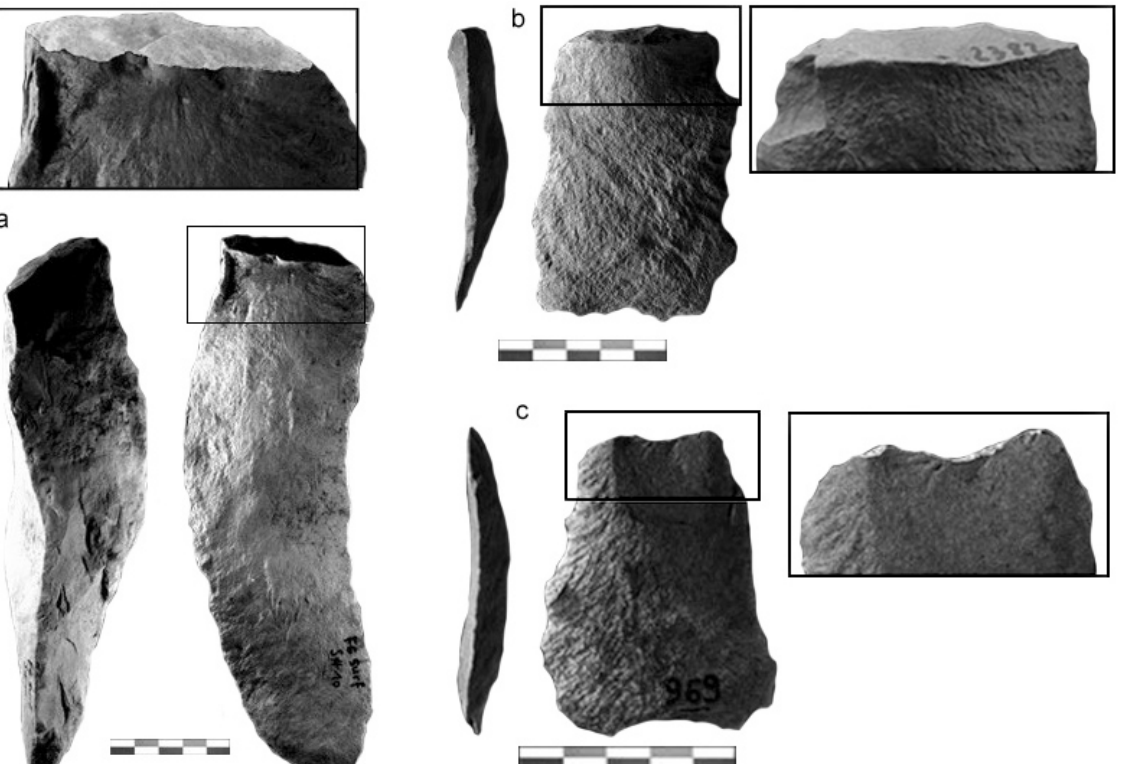
Figure 2. Vues photographiques des stigmates caractéristiques de (a) la percussion dure minérale, (b) la percussion tendre minérale, et (c) percussion tendre végétale, sur des basanites à grains fins. Echelle de 5 cm (segments de 1cm). Figure 2. Stigmas of (a) hard mineral percussion, (b) soft mineral percussion, and (c) soft wood percussion, on fine-grained basanites. The scale bars in the images are 5 cm wide (separated into 1 cm